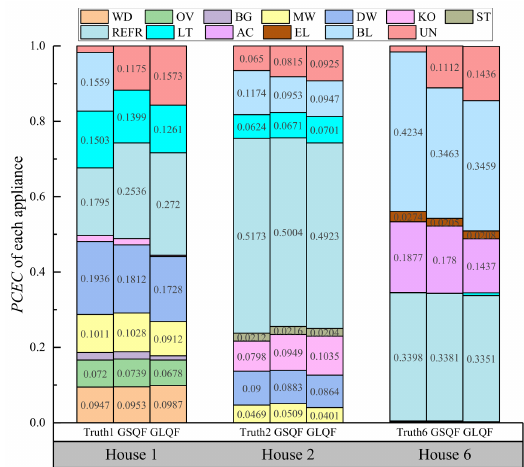
Figure 5. Comparison of appliance contribution to the total energy in Houses 1, 2, and 6 for GSQF-APD and GLQF-APD. Remarks: GSQF and GLQF in the figure refer to GSQF-APD and GLQF-APD, respectively.